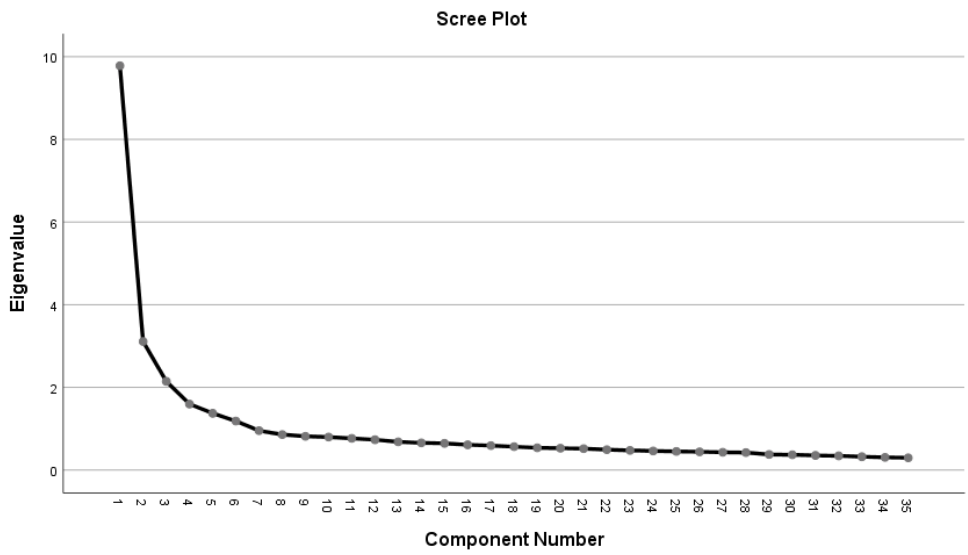
Figure 1 Scheme of latent roots of the constituent factors of the tolerance index.